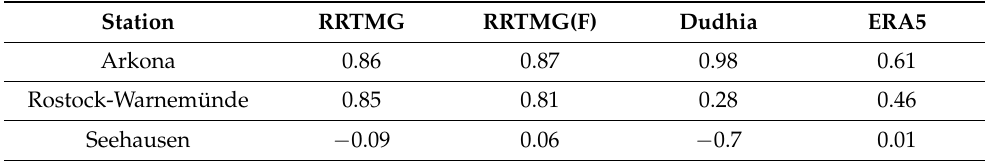
Table 6. Summary of correlation coefficients for occluded fronts. Station RRTMG